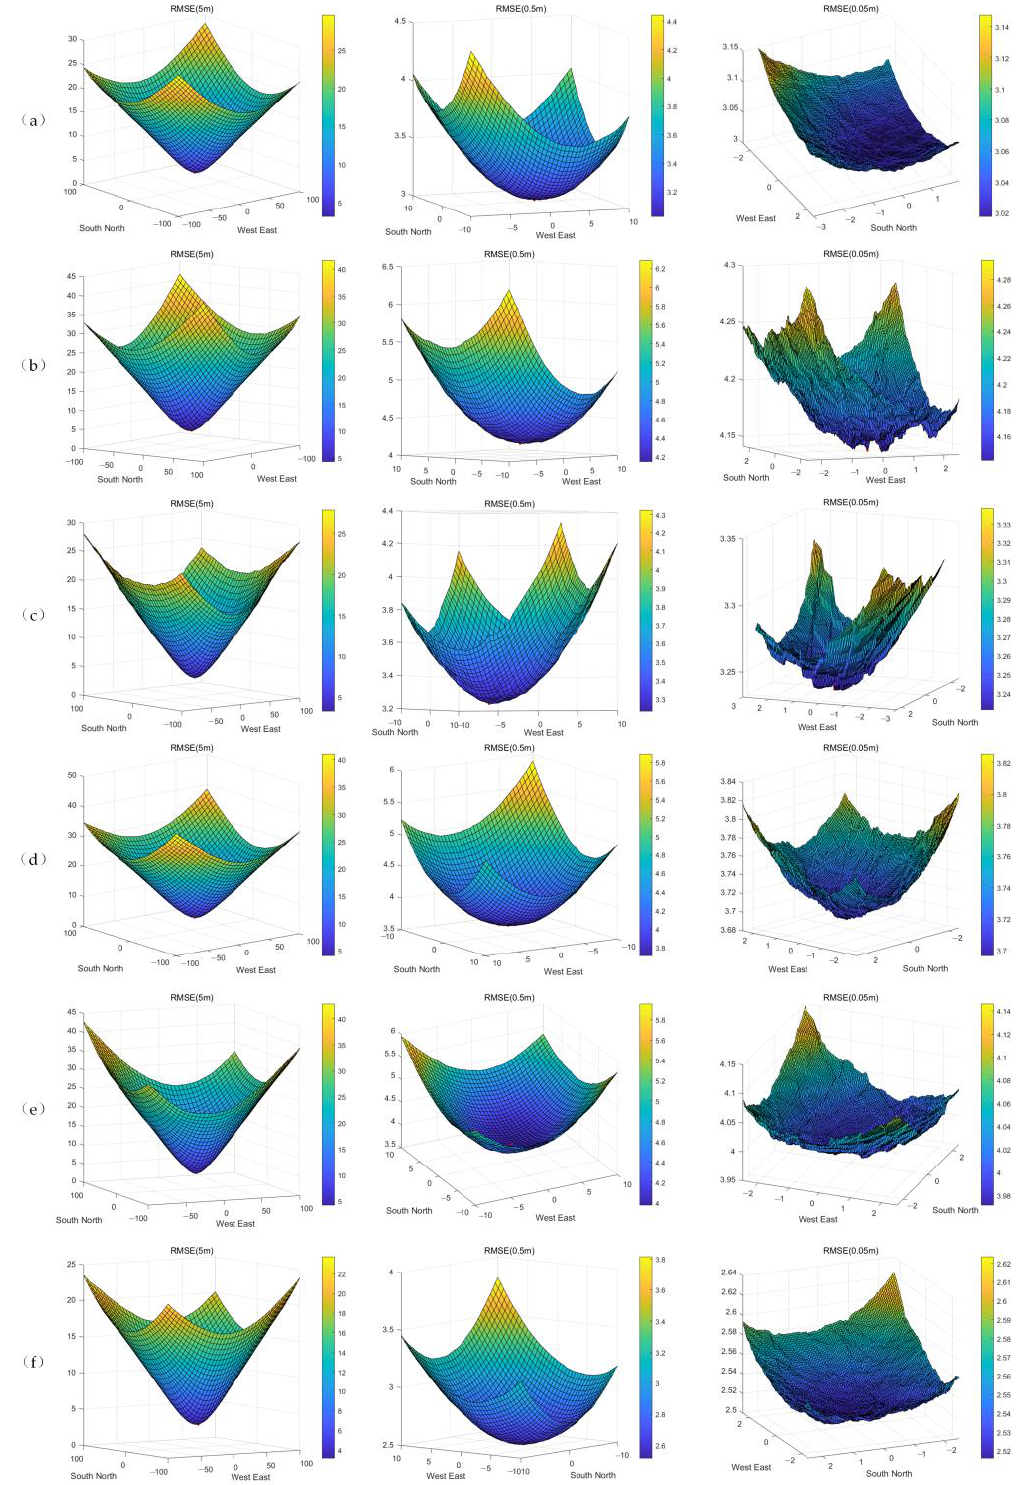
Figure 5. Schematic diagram of the pyramid registration result. ( a ) Gangnalou Glacier, ( b ) Laohugou No. 12 Glacier, ( c ) Dunde Ice Cap, ( d ) the 93.5°E 39.2°N Glacier, ( e ) Shiyang River, Bayi, and Suzhulian Glacier Group, and ( f ) the 97.2°E 38.7°N Glacier. The values in the squares represent the dh RMSE, where ICESat-2 and the ALOS DEM are located on stable terrain. Each axis scale unit represents the resolution of the corresponding layer. For example, the first column is the first layer registration (5 m resolution), that is, one grid represents 5 m. The second column is the second layer registration (0.5 m resolution), that is, one grid represents 0.5 m. Table 2. Offset vector size. X direction offsets to the east are positive, and Y direction offsets to the south are positive. Glacier Area X Direction Y Direction Z Direction